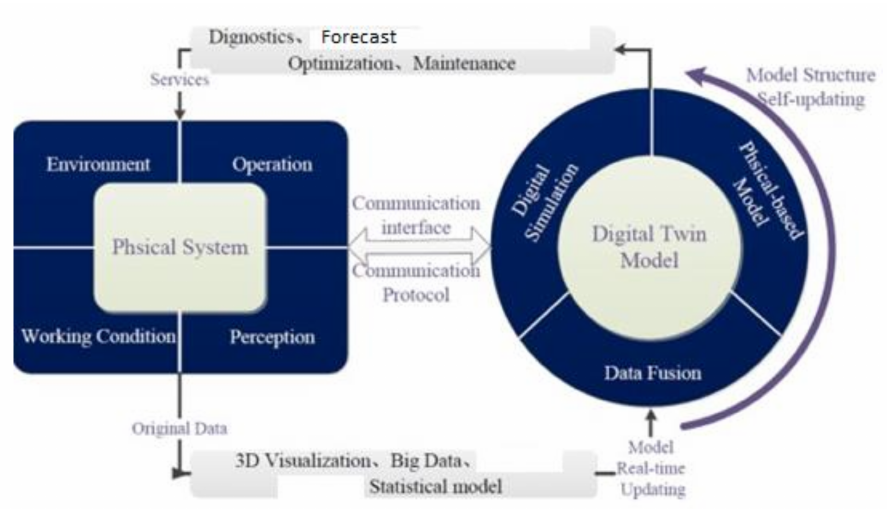
Figure 19. Digital twin